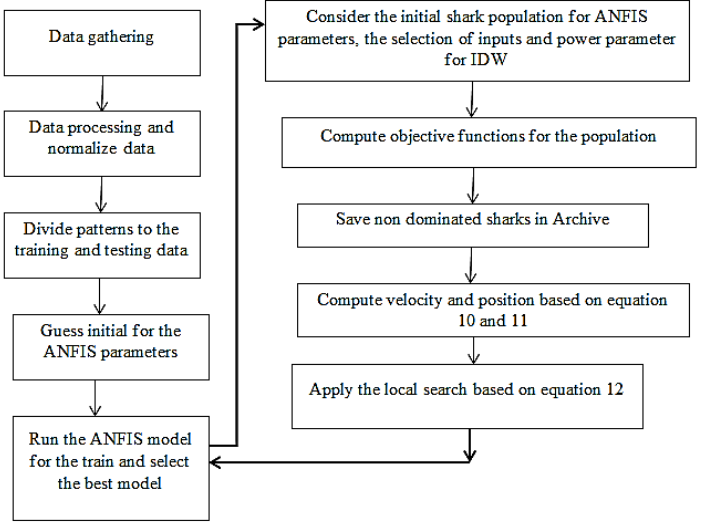
Figure 4. MOSA and ANFIS structure.